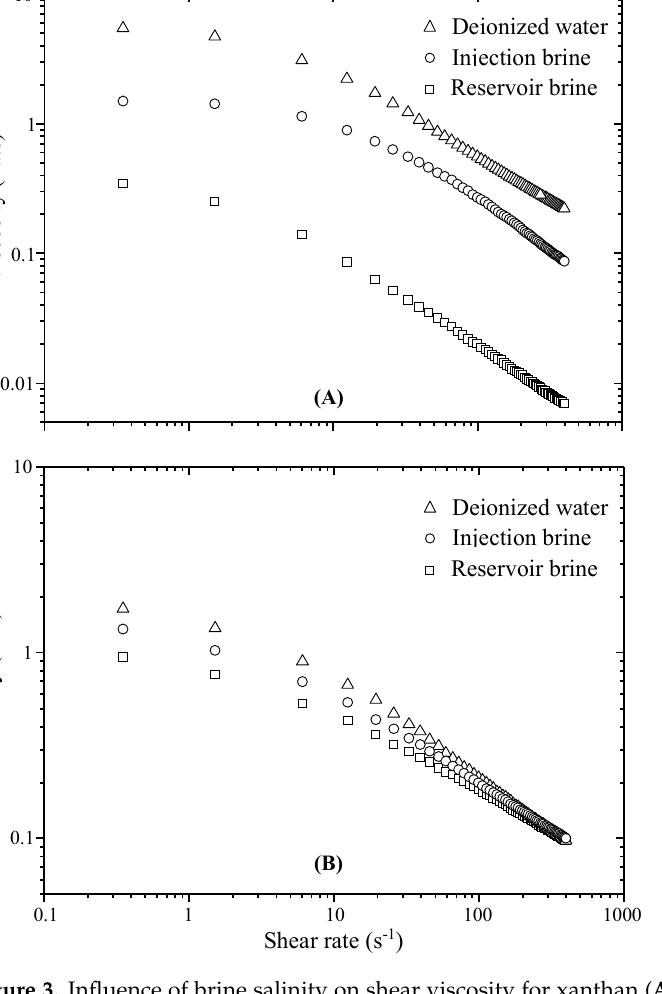
Figure 3. Influence of brine salinity on shear viscosity for xanthan ( A ) and grafted xanthan-brine solutions ( B ). (Polymer concentration = 2000 ppm).